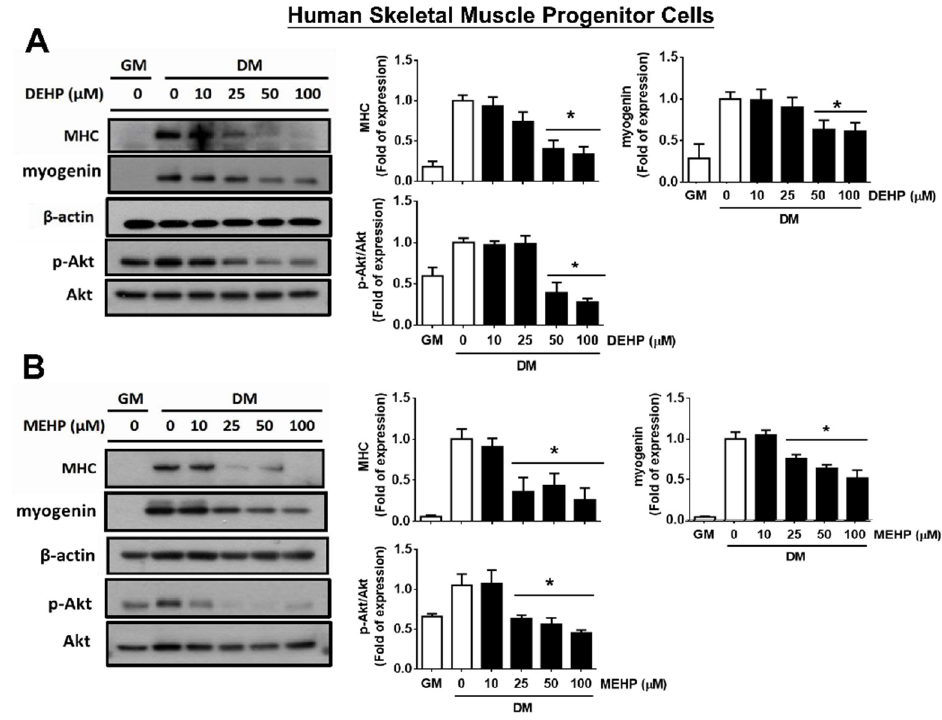
Figure 6. The changes in myogenesis-related protein expression in primary HSMPCs treated with both DEHP and MEHP. Under differentiation medium (DM), HSMPCs treated with DEHP ( A ) or MEHP ( B ) (10–100 µ M) were observed. GM indicated as growth medium. The analysis of protein expression for myogenin, myosin heavy chain (MHC), phospho-Akt, and Akt was performed using Western blot. An internal control using β -actin was performed. The densitometric analysis of proteins via Western blot was performed. Data are presented as means ± SEM (at least three independent experiments, triplicate repeats in each); p < 0.05 indicates significance compared to the control